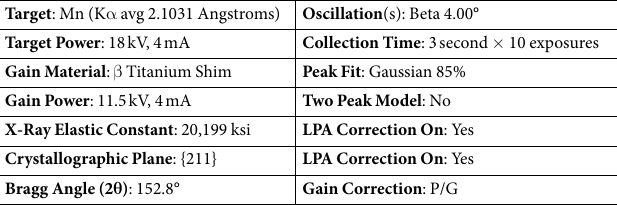
Table 1. Parameter of XRD stress